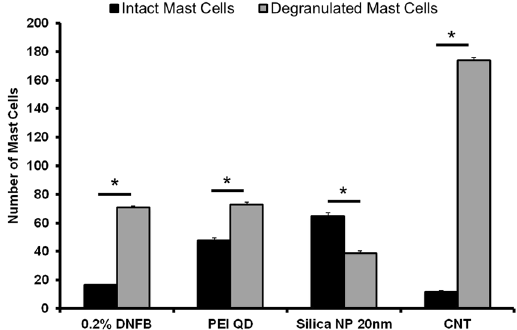
Figure 8. Mast cells quantified in the ear tissue by IHC using the Geimsa stain. The number of degranulated MCs was significantly lower in the silica NP (20 nm) treatment group compared to PEI-QD and CNT treated ears co-challenged ear. MCs were counted in 10 fields of view at 40X for 3 independent mouse skin samples. Mean ± SEM, * p < 0.05, 2-tailed Student’s t-Test, paired, with respect to intact mast cells in each group. Error Bars: Standard